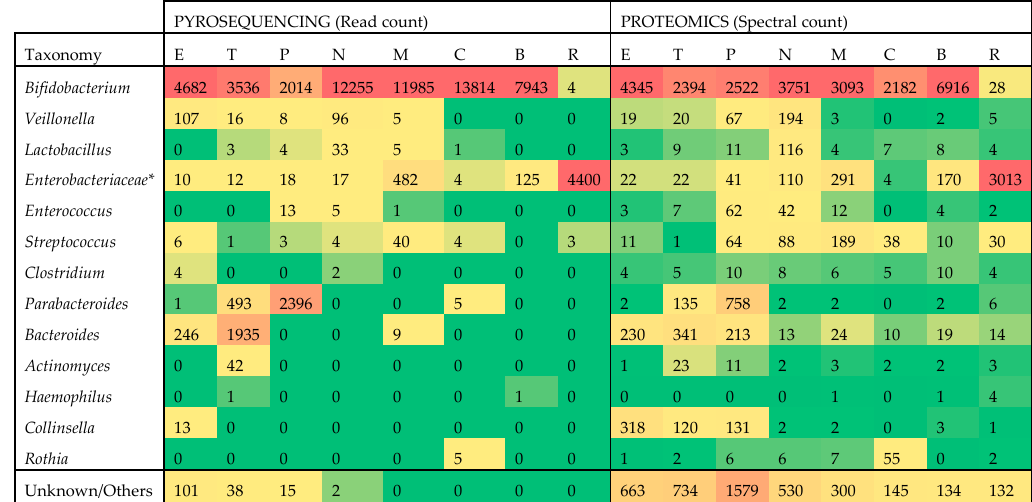
Figure 1. Heat map comparison of pyrosequencing and metaproteomics results across the most abundant taxa. Data is summarized at the genus level, except for the family Enterobacteriaceae which incorporates multiple genera to simplify comparisons. Values are colored in shades of green to yellow to red, indicating low, medium and high abundance, respectively. Actual read counts and spectral counts are also provided. Subjects are identified by a letter code here and in other figures and tables (E, T, P, N, M, C, B, R).